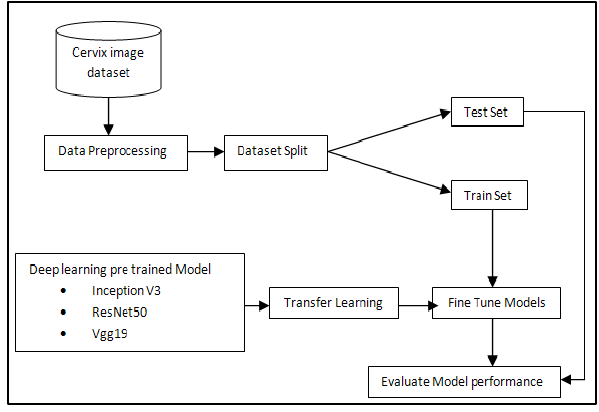
Figure 3. Proposed Architecture